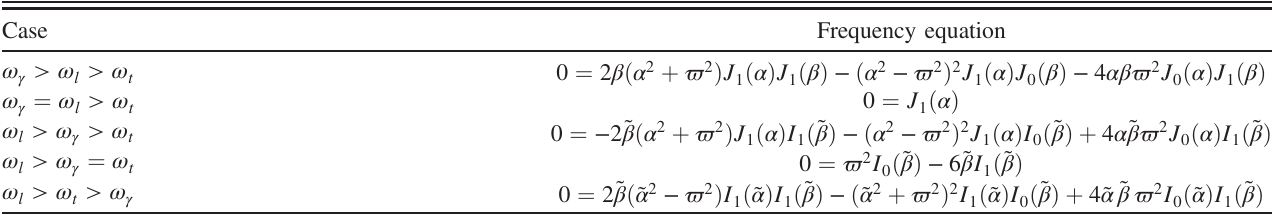
TABLE XIV. Longitudinal (L) fiber eigenmodes: Frequency equations. All quantities are defined in Table IX.